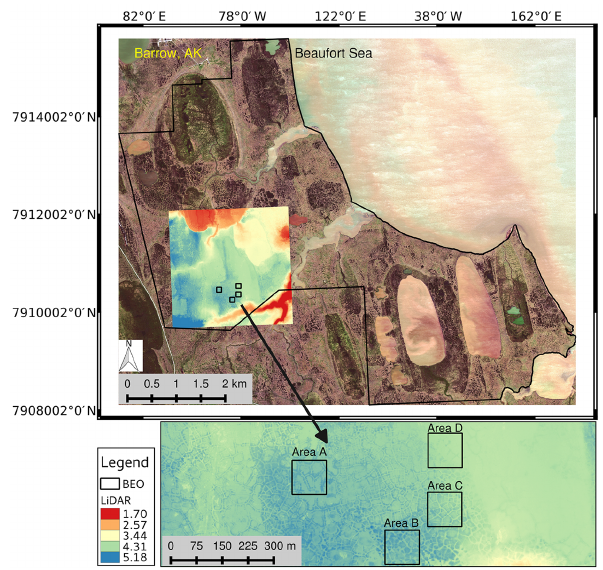
Figure 1. NGEE Arctic field sites at BEO (lidar elevations are in units of meters above mean sea